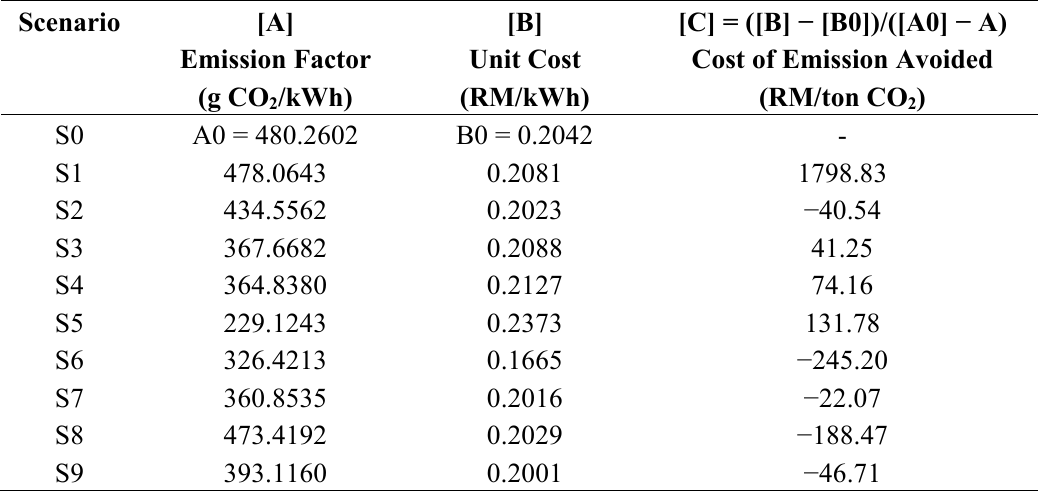
Table 3. Cost of GHG emission